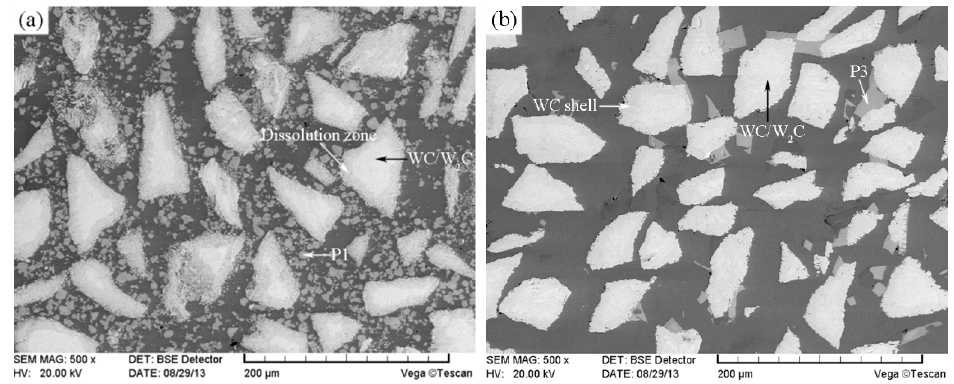
Figure 10. Typical SEM images of ( a ) the unmodified, and ( b ) the modified CTC P -NiCrBSi used for quantitative image analysis.